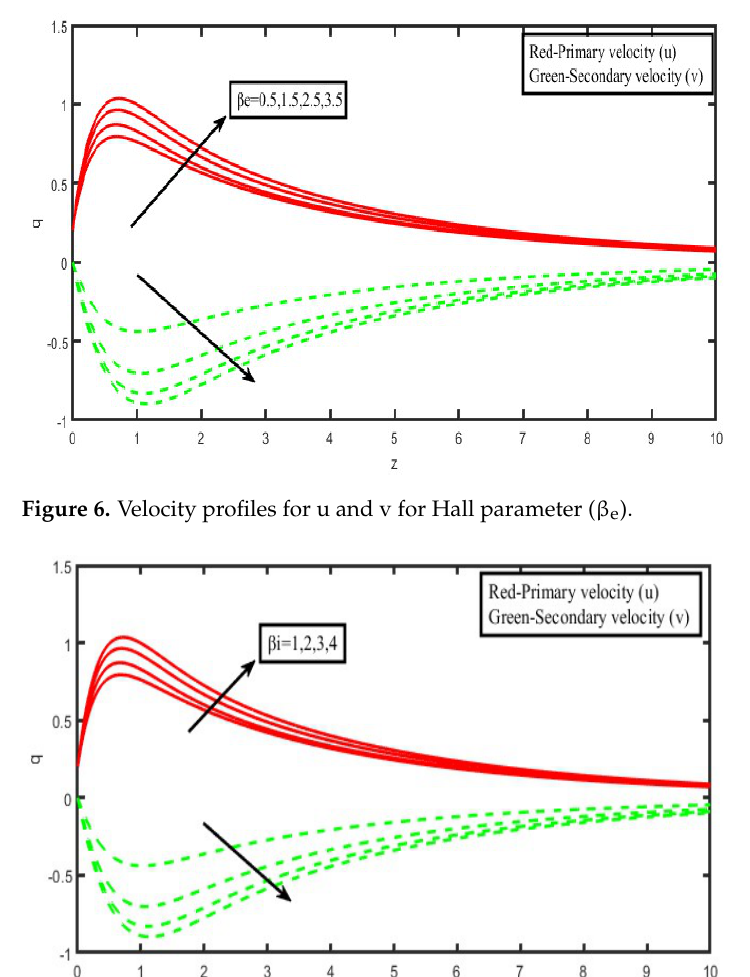
Figure 5. Velocity profiles for u and v for Permeability of porous media (K).